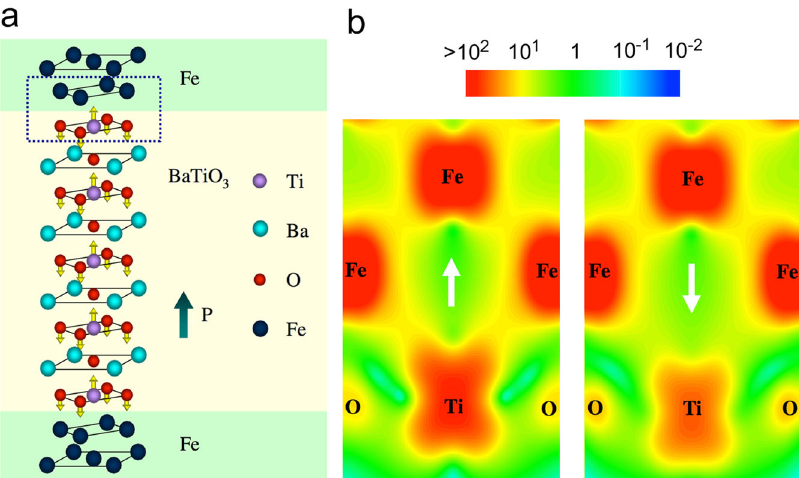
Fig. 5 a Atomic structure of the Fe/BaTiO 3 /Fe multilayer with a super cell of (Fe 2 ) 9 – TiO 2 – (BaO – TiO 2 ) 4 , in which the arrows schematically indicate the displacements of the Ti and O atoms. b The calculated minority spin densities (in arbitrary unit) at the upper Fe/BaTiO 3 interface (marked by dashed rectangular in a ). Adapted with permission.